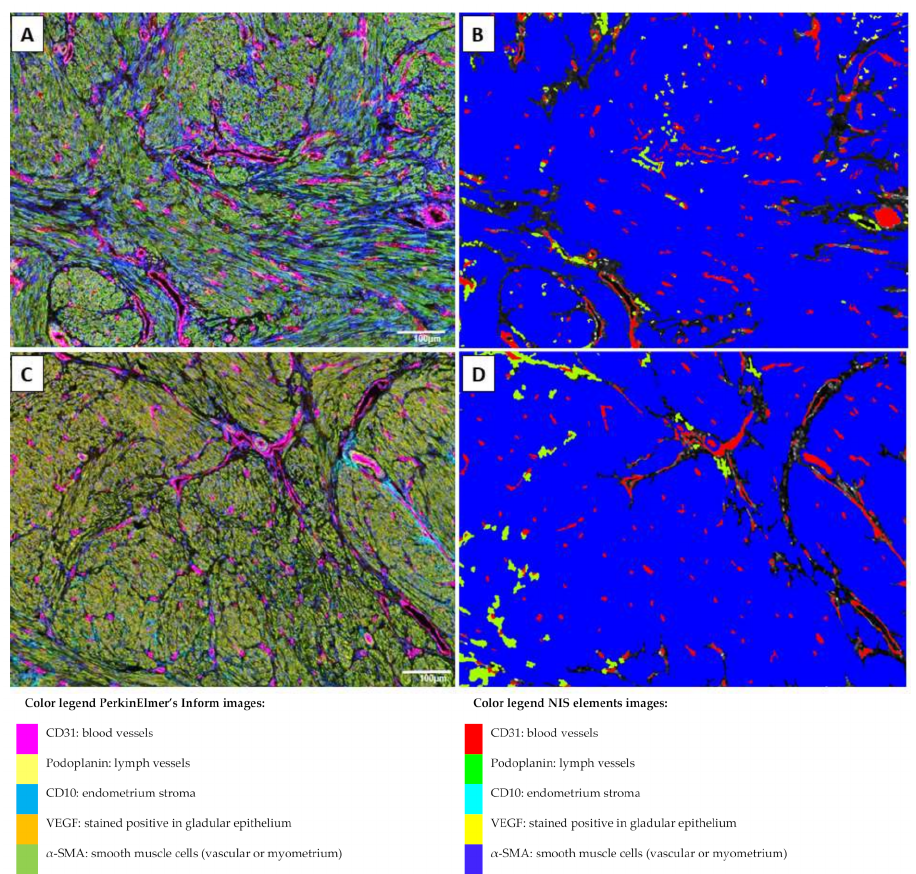
Figure 2. Multiplex images viewed in PerkinElmer’s inForm ® advanced image analysis software ( A , C ) and analysis of multiplex images in NIS Elements using binary layers for an automated analysis ( B , D ) of control myometrium ( A , B ), and adenomyosis myometrium ( C , D ). All magnifications were × 200 with each field representing 0.9 × 0.7 mm.